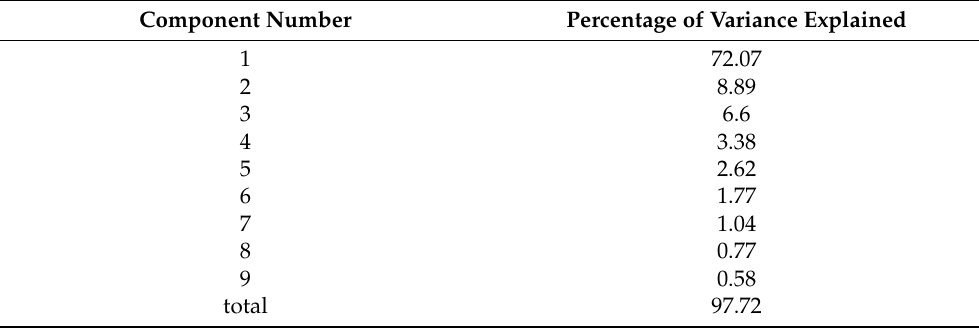
Table 1. Percentage of variance of the selected components of PCA on 500 hPa geopotential height in